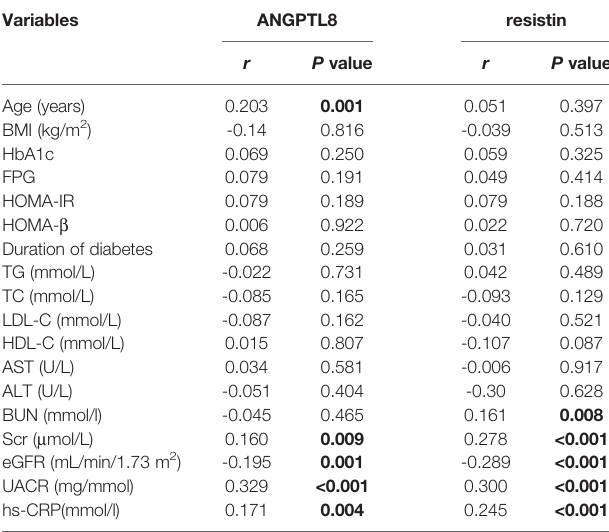
TABLE 2 | Correlations of ANGPTL8 and resistin with anthropometric parameters and biochemical indexes in all patients.